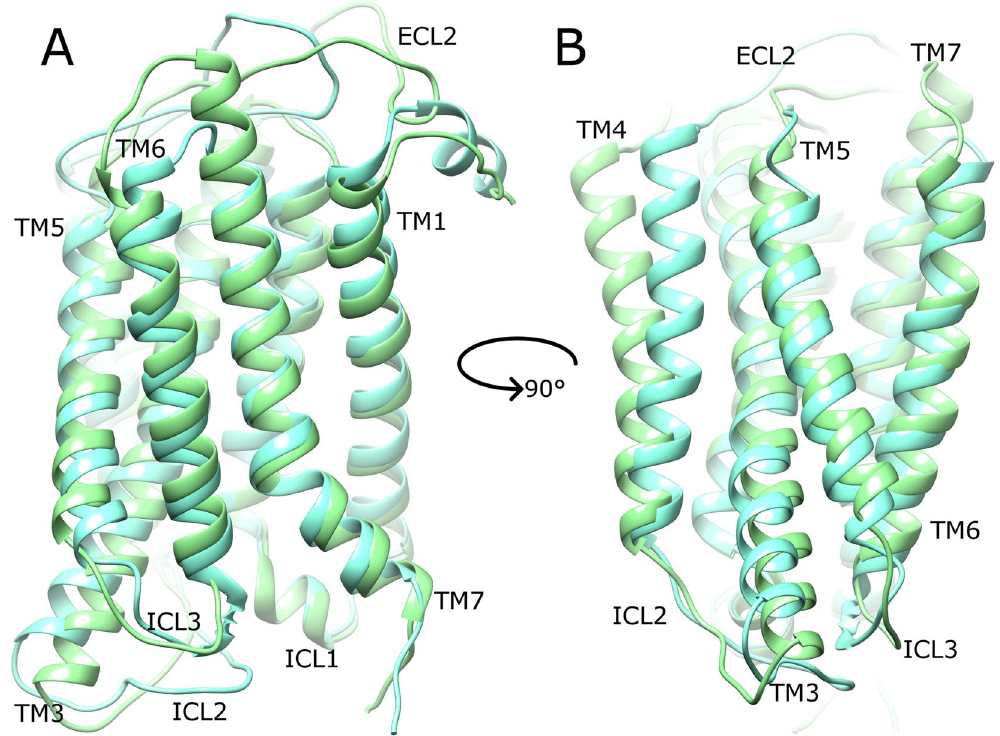
Figure 2. Average conformation of mGlu4 (light green) and mGlu5 (cyan) in their apo states, obtained from respective MD simulations, showing a 90° rotation between ( A ) and ( B ) around the membrane plane (extracellular-side: top, intracellular-side: bottom). Average receptor states are calculated from respective MD simulations (between 2.5–5 µ s). Relevant structural features are labelled: extracellular loops (ECLs), intracellular loops (ICLs) and transmembrane helices